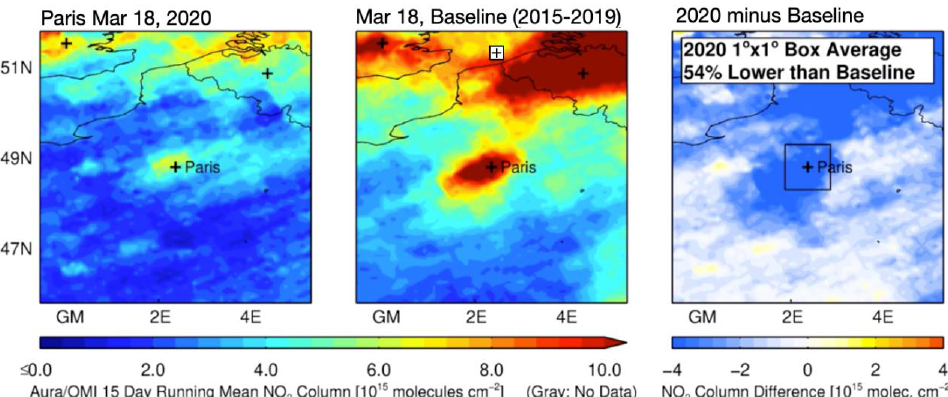
Figure 12. Nitrogen dioxide concentrations over Paris on 18 March of 2020 and on 18 March from the period of baseline (2015–2019). Source: NASA AURA [23].